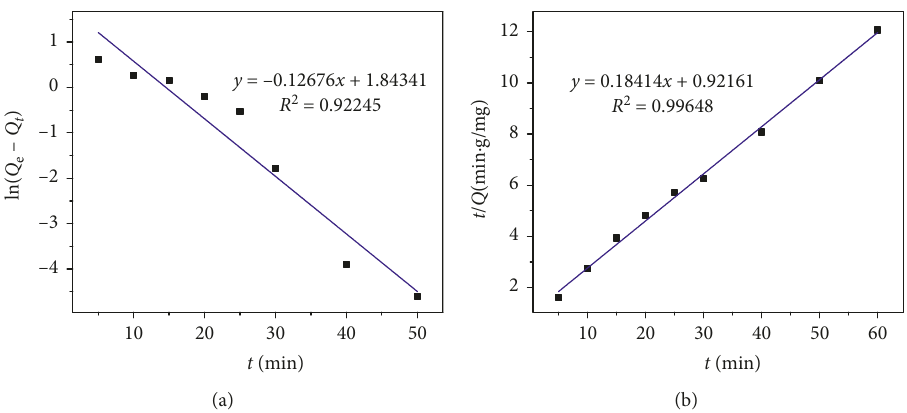
Figure 14: The description of the experimental data by (a) pseudo-first-order and (b) pseudo-second-order kinetic equations. Table 6: The values of k and Q e calculated from pseudo-first-order and pseudo-second-order kinetic equations. Pseudo-first-order kinetic equation Pseudo-second-order kinetic